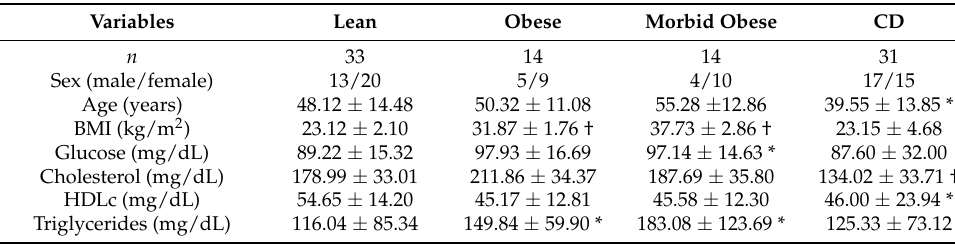
Table 1. Anthropometric and biochemical variables of